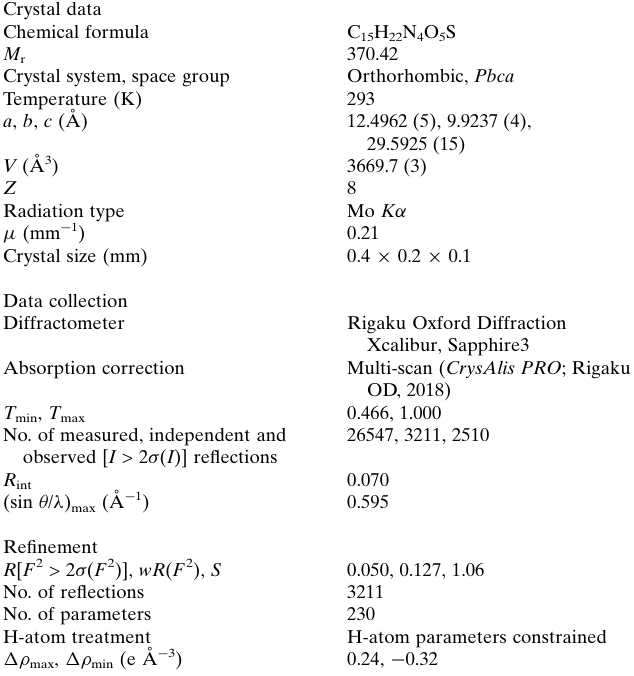
Table 5 Experimental details. Crystal data Chemical